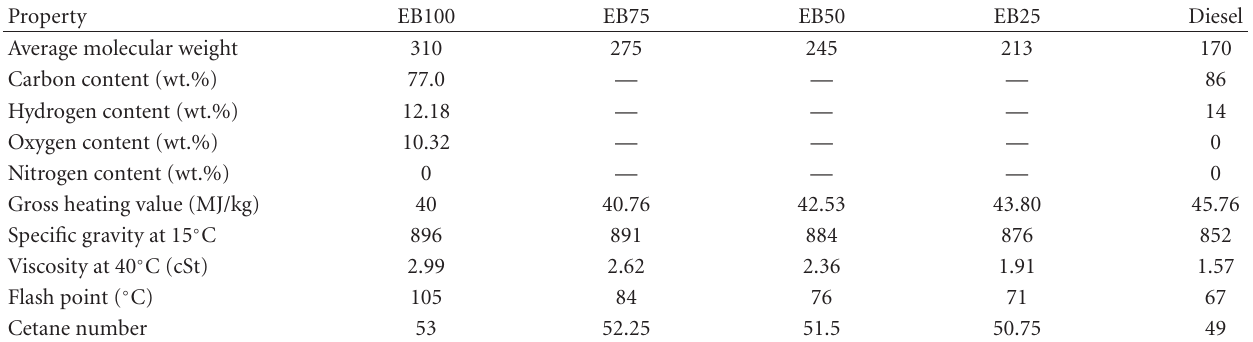
Table 1: Properties of tested fuels.